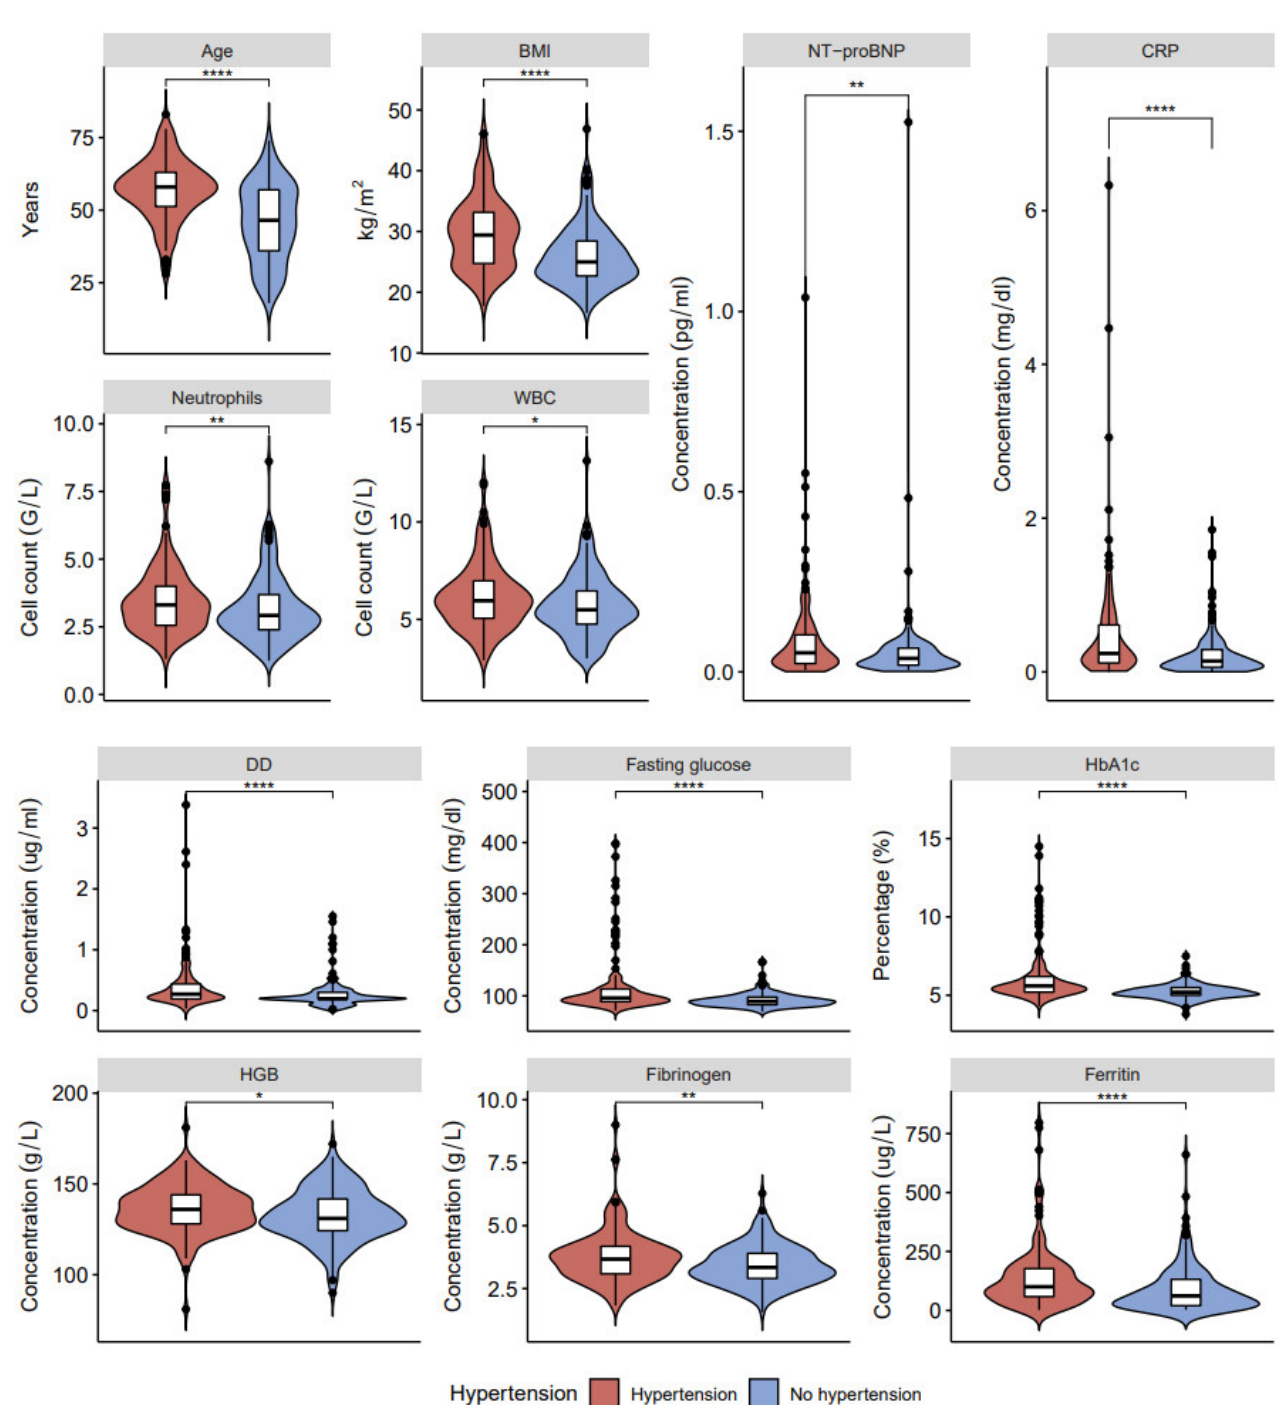
Figure 3. Clinical characteristics and laboratory results of blood samples in post-COVID-19 patients with and without hypertension: age, BMI, NT-proBNP, CRP, neutrophils, white blood cells (WBC), DD, fasting glucose, HbA1c, HGB, fibrinogen, and ferritin (* p < 0.05, ** p < 0.01, **** p < 0.0001).